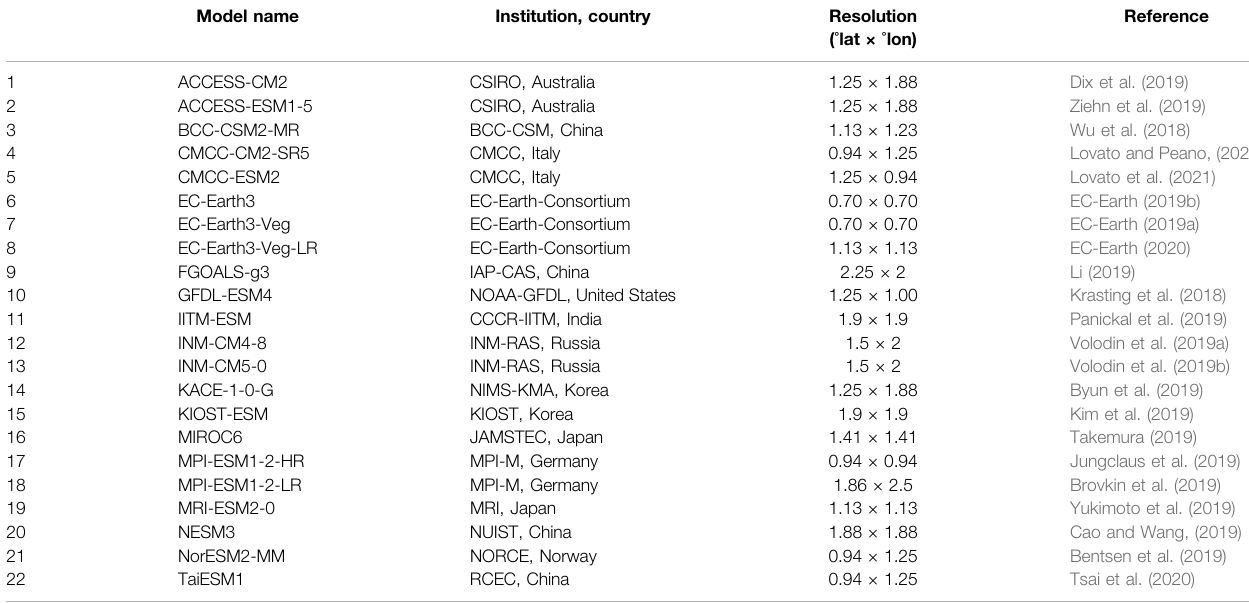
TABLE 1 | Information on the 22 CMIP6 global climate models used in this study. Model name